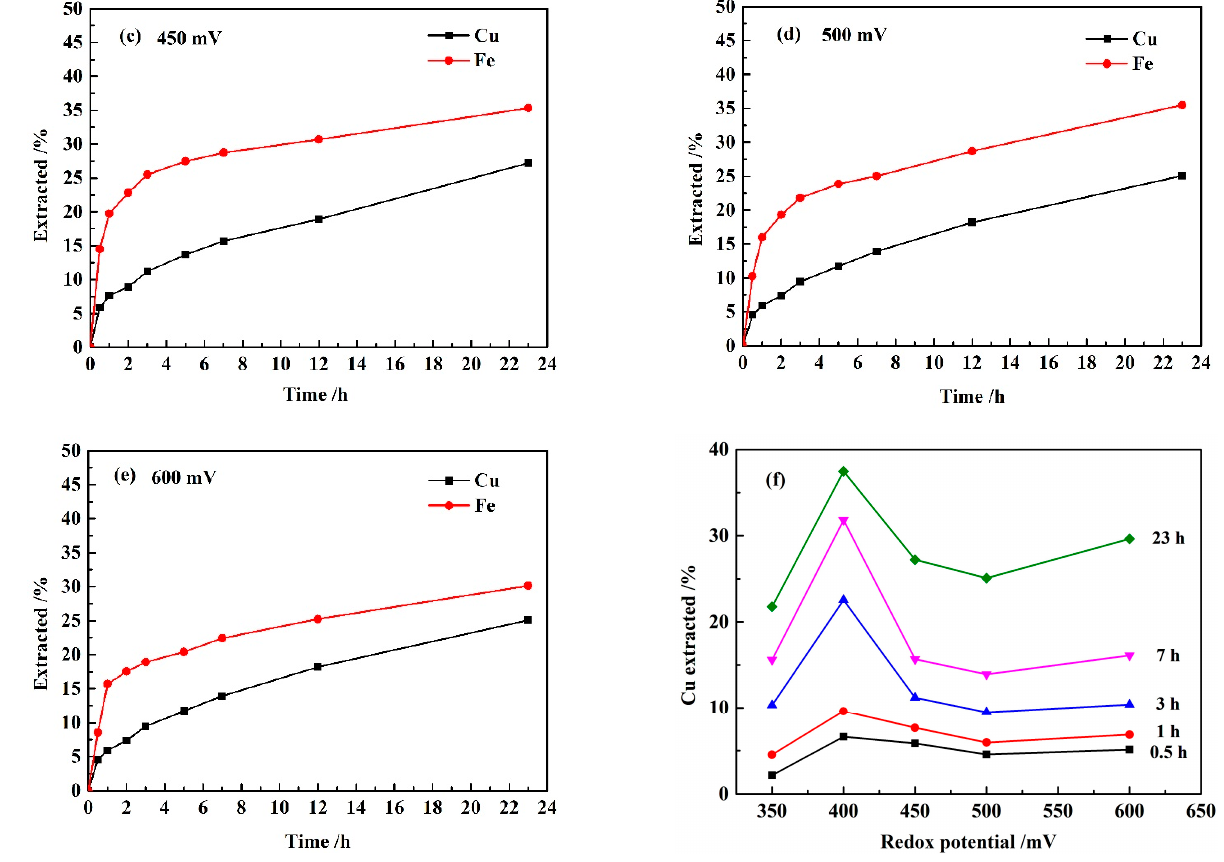
Figure 5. In the controlled redox potential test process, the redox potentials ( a – e ) were fixed at 350 mV, 400 mV, 450 mV, 500 mV and 600 mV, respectively, showing the Cu and Fe leaching rates at different times; ( f ) Cu leaching rate at different redox potentials.